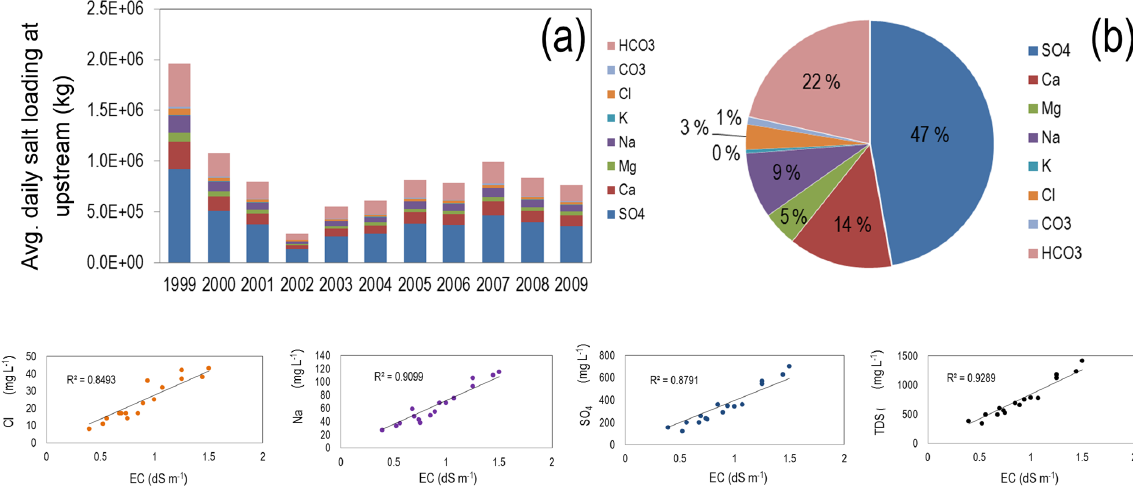
Figure 4. Data summarizing the specified loading of salt (kgd − 1 ) at the Catlin Dam gage site, using observed EC (dSm − 1 ) and stream discharge (m 3 d − 1 ) data: (a) daily loading of salt ion, (b) percentage of total salt loading attributed to each salt ion, and (bottom charts) example regression plots used to relate EC to salt ion